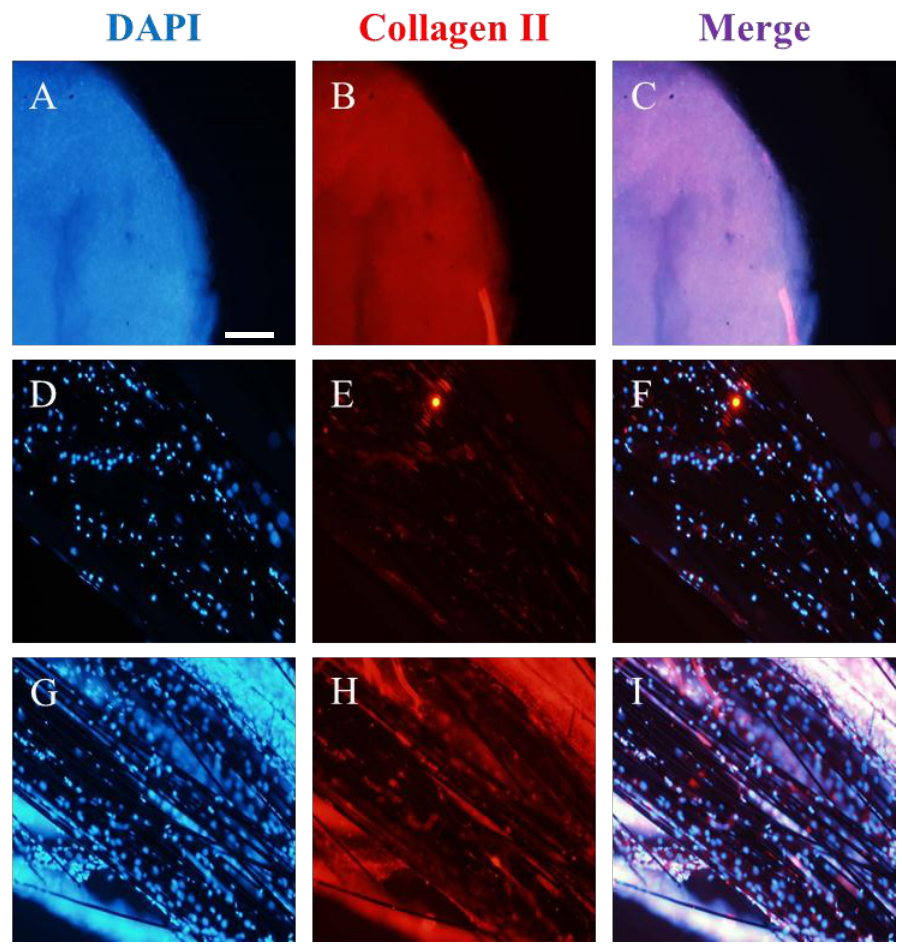
Figure 5. Induction of hMSC chondrogenesis on 3D-printed polyamide–carbon fibril composite by CM-hMSC functionalization. A quantity of 2 × 10 4 hMSCs control micro-masses ( A – C ), or seeded on 3D-printed polyamide–carbon fibril composite ( D – F ), or seeded on 3D-printed polyamide–carbon fibril composite pre-treated with hMSC-CM ( G – I ). Blue represents hMSCs nuclei (DAPI) and red indicates immunodetection of collagen type II. Scale bar represents 50µm.